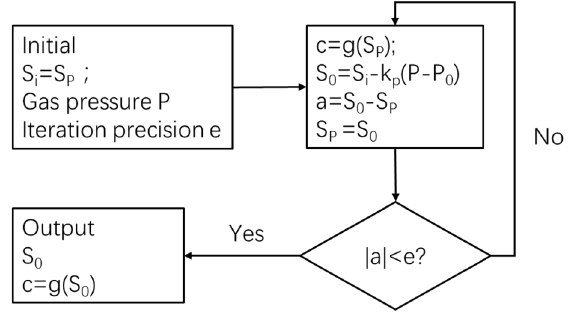
Figure 14. Flowchart of the correction iteration process.